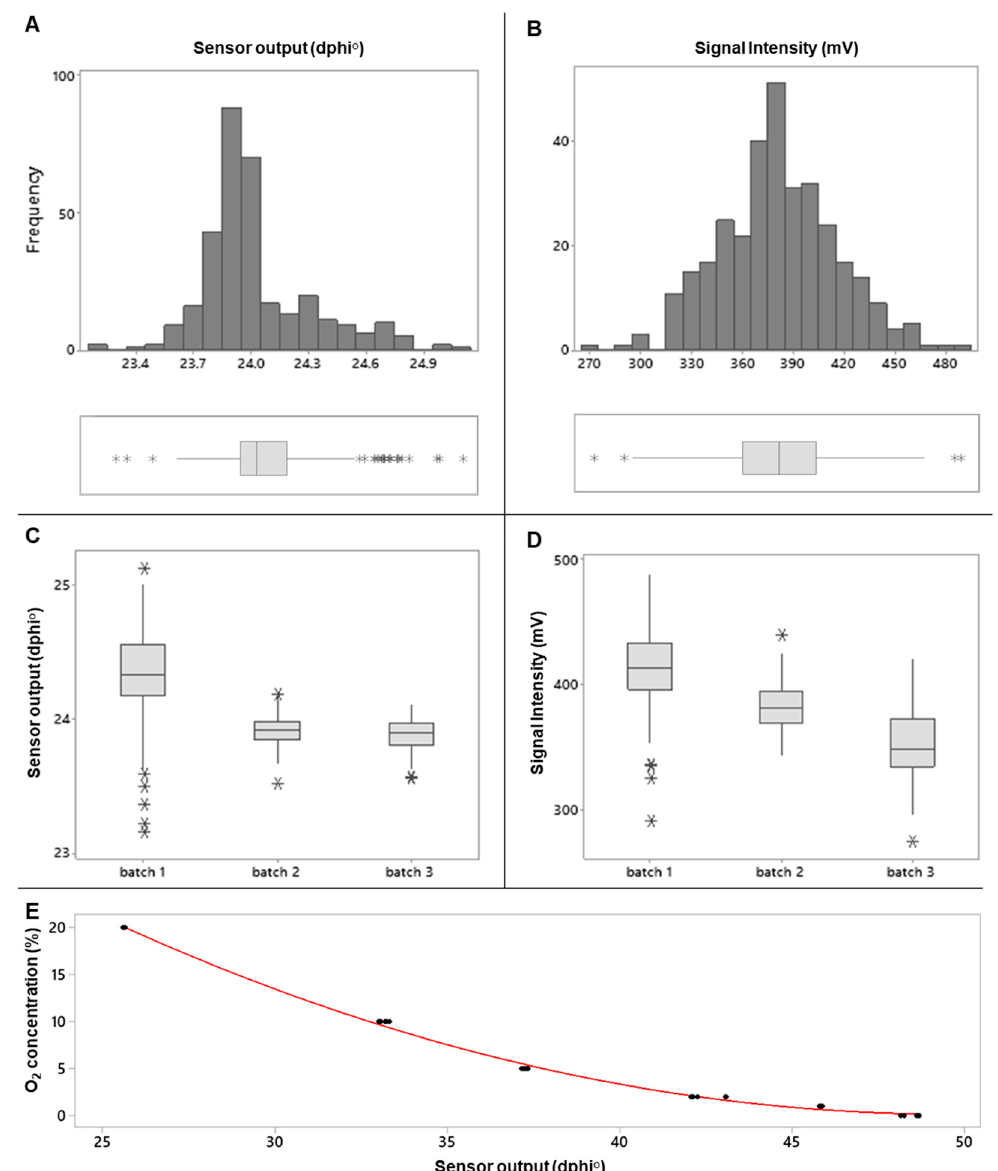
Figure 2. Initial quality check and O 2 calibration for the disposable sensor dots. Quality check on sensor dots prior to use. The box plots show the distribution of the measured values. Histograms of the data (n = 137) show the distribution of the measured sensor dphi ◦ ( A ) and intensity (mV) signals ( B ), and their corresponding box plots. Box plots ( C , D ) show the dphi ◦ and mV values for the three batches (95 dots each) produced on three different days. The boxes show the interquartile data ranges (n = 100). The horizontal line in each of the boxes represents the median value. The whiskers represent the ranges for the bottom 25% and the top 25% of the data values, and * repre ‐ sent outliers. ( E ) The O 2 calibration curve for sensor dots; the red line indicates the polynomial fitting curve.